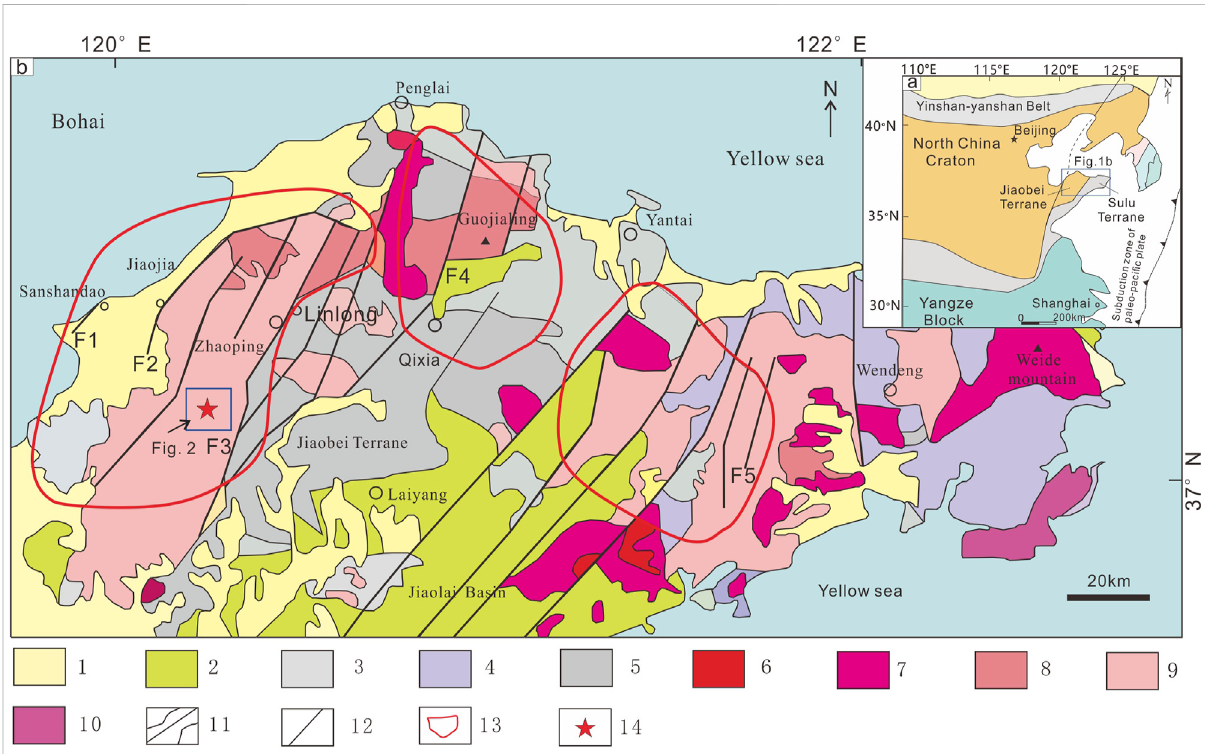
FIGURE 1 Simpli fi ed regional geological map, modi fi ed after Wu et al. (2022). (A) Simpli fi ed regional geological map of NCC; (B) Regional geological map of Jiaodong gold province. 1- Quaternary; 2- Mesozoic; 3- Proterozoic; 4- Neoproterozoic gneiss; 5- Archean greenstone belt; 6- Cretaceous Laoshan granite; 7- Cretaceous Weide mountain granite; 8- Cretaceous Guojialing granite; 9- Jurassic Linglong granite; 10- Triassic granite; 11- Geological boundary; 12- Fault; 13- Gold deposit accumulation region; 14- Laixi gold desposit; F1-Sanshandao fault; F2- Jiaojia fault; F3- Zhaoping fault; F4-Xilin-douya fault; F5-Jinniushan